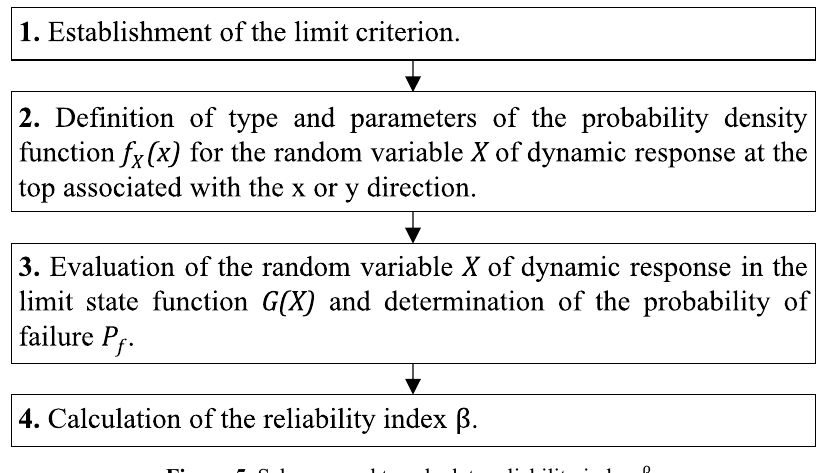
Figure 5. Scheme used to calculate reliability index β